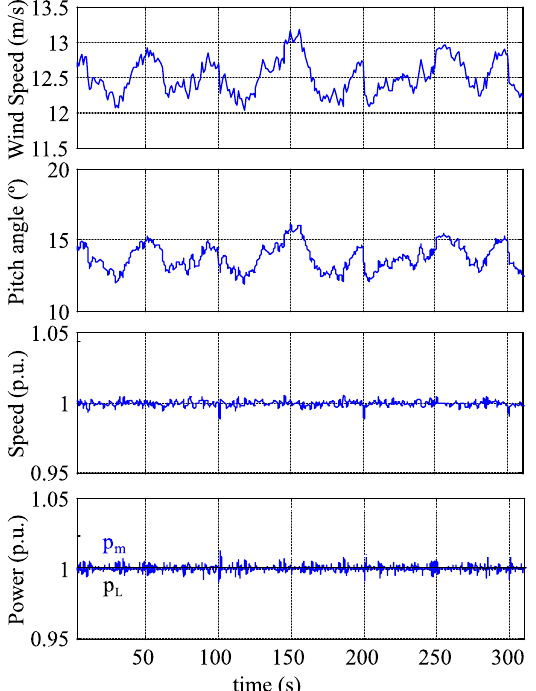
Figure 9. Real-time system response to wind